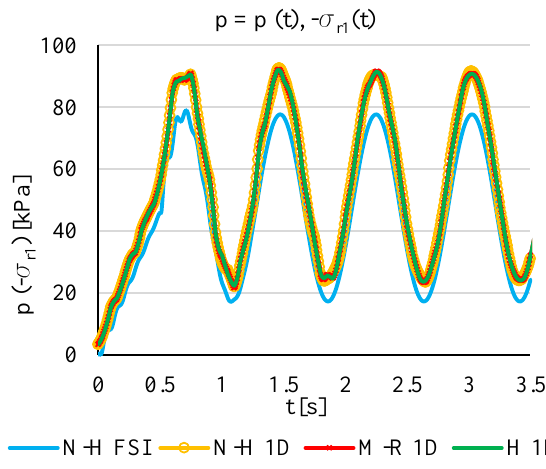
Fig. 11. Static pressures p in the thick-walled tube. Fig. 15 and Fig. 16 show axial stresses σ a1 a σ a2 . However, the axial stresses would not differ from the outer and inner tube surfaces. Differences in axial stresses on the outer and inner tube surfaces are minimal in the case of ANSYS FSI simulation and are therefore shown as one stress. There are insignificant